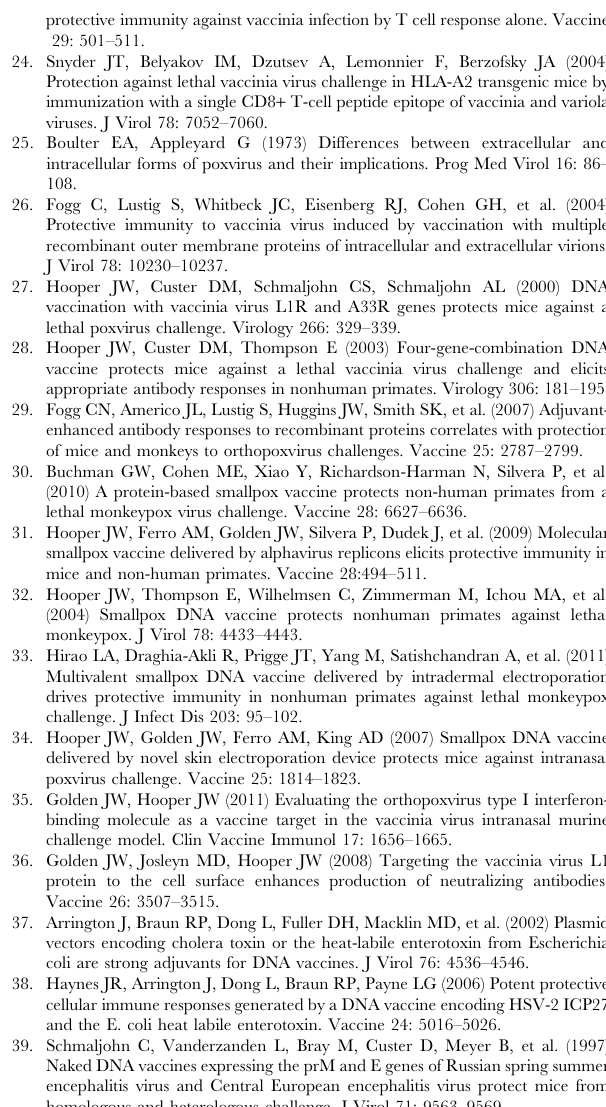
lenged with MPXV. A . Weight loss in 4pox/LT or sham vaccinated NHPs was monitored at the initiated time points. starting values determined 6 days before to challenge. B .